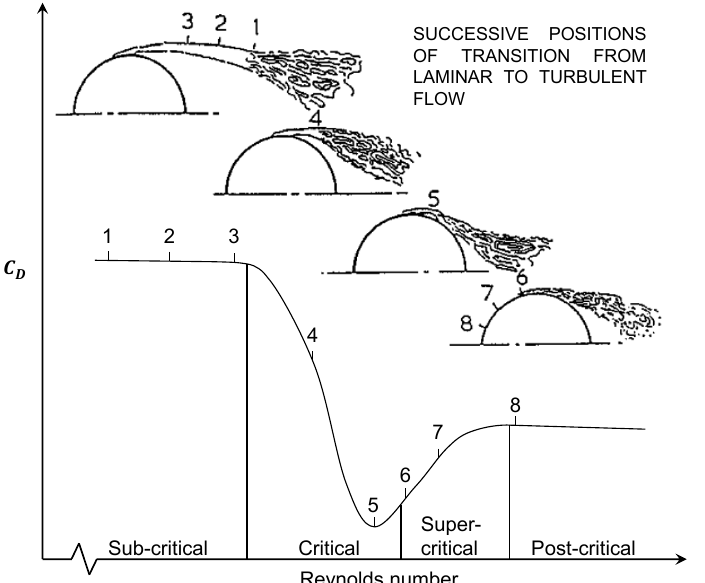
Figure 6. Influence of the boundary layer in the sub-critical to post-critical flow regimes, smooth circular cylinder in steady flow [31].